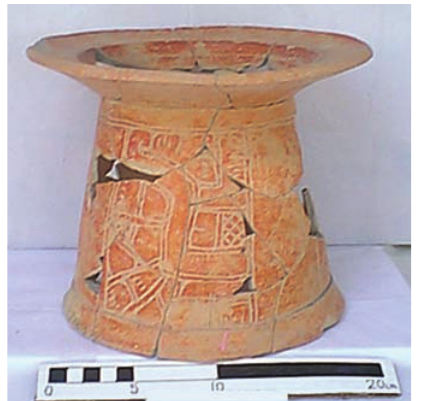
Figure 6 David Pendergast termed this form a “chalice” due to its high pedestal base. These large, elaborate vessels are characteristic of the Postclassic period at Lamanai and were frequently smashed over burials.